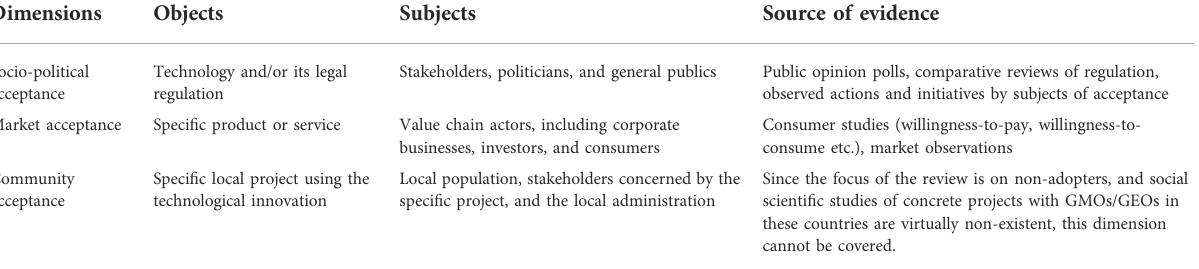
TABLE1Dimensions ofsocialacceptancebasedonWüstenhagen etal.(2007)andSonnberger andRuddat(2017),theircharacteristics andwhattype of evidence is considered relevant and used in this review.